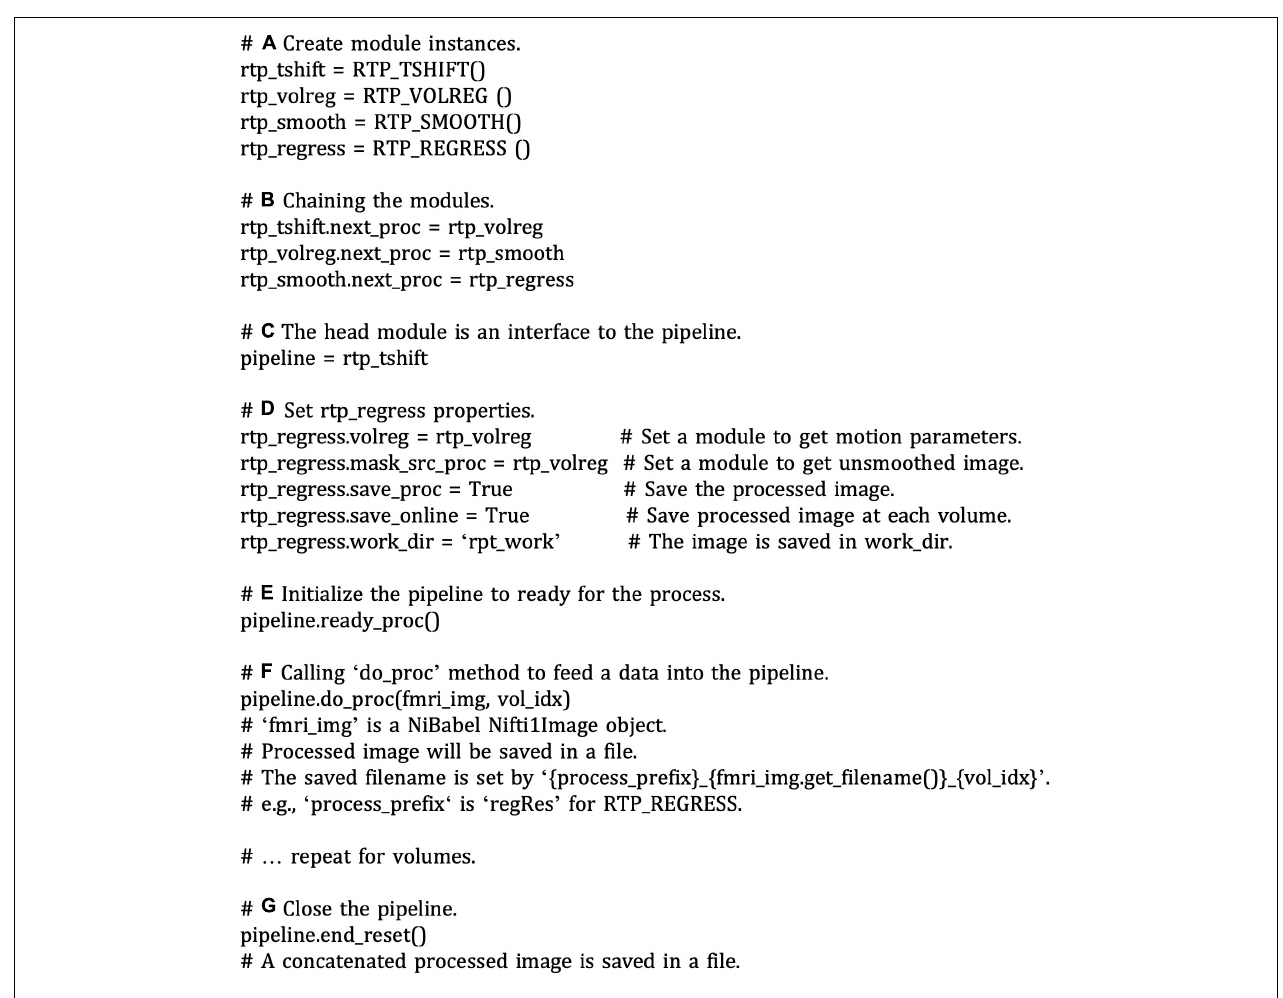
FIGURE 5 | A pseudo script of low-level interfaces of pipeline creation with RTPSpy. The comments with bold alphabet indicate a part of the script explained in the main text. To make a pipeline, we should create instances of each processing module (A) and set a chaining module to the “ next_proc ” property (B) . The head module can be used as an interface to the pipeline (C) . Properties of the modules in a pipeline can be directly accessed and set by the module instances (D) . Calling the “ redy_proc ” method initializes the pipeline (E) . The processing is run by feeding a NiBabel Nifti1Image object to the “ do_proc ” method of the pipeline (F) . The pipeline is closed by calling the “ end_reset ” method (G)